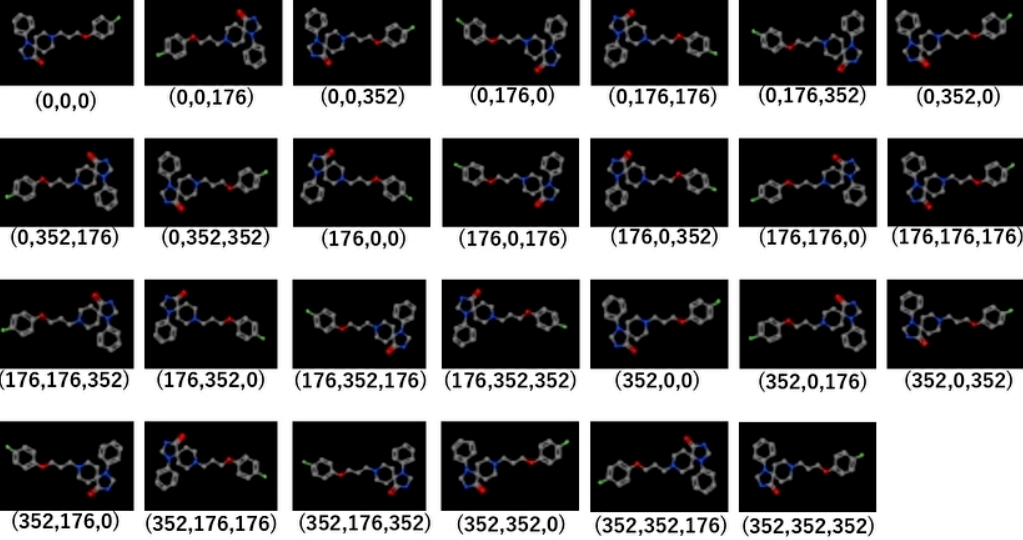
Figure 2. Representative molecular images used in the DeepSnap-DL method. The parentheses below each image indicates the angles of depiction in DeepSnap.